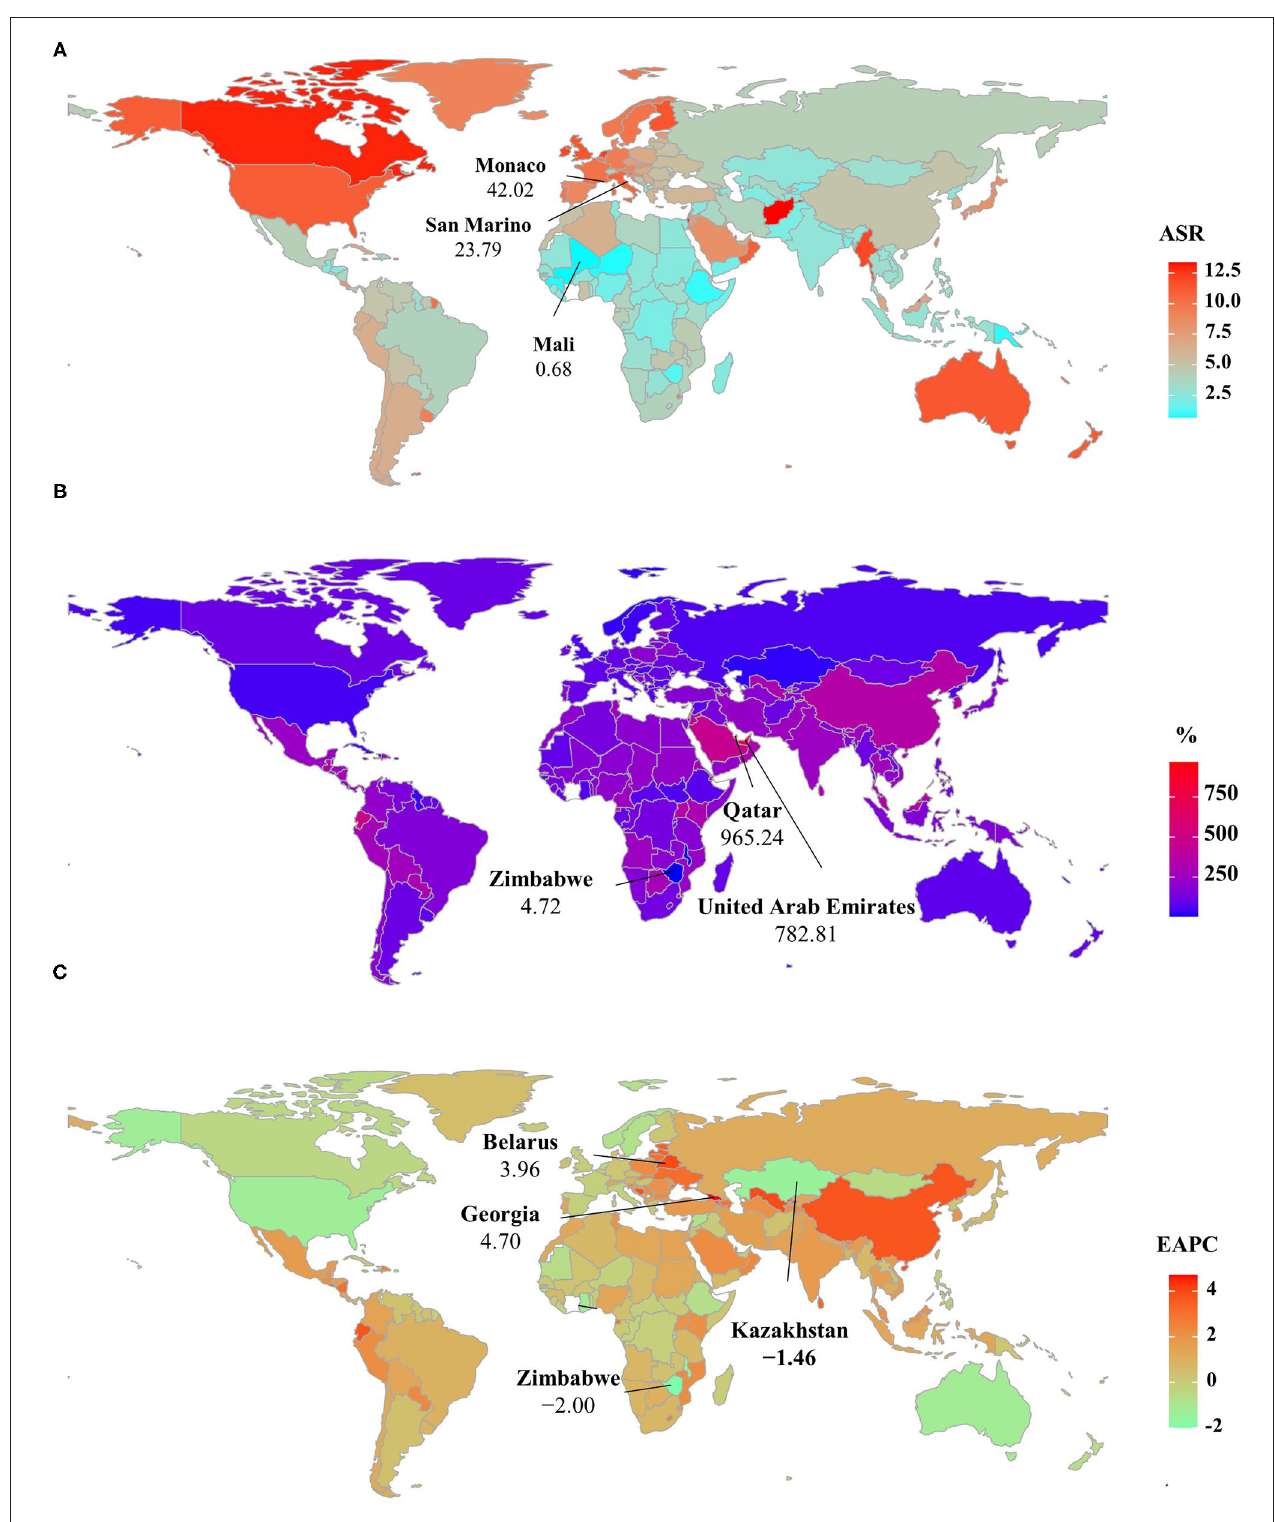
FIGURE 3 | ASIR, percentage changes in the incident number, and EAPCs of non-Hodgkin lymphoma at the national level, 1990–2019. (A) ASIR in 2019; (B) percentage changes in incident numbers between 2000 and 2019; (C) distribution of EAPCs presented in countries/territories. Countries/territories with extreme values were annotated. ASIR, age-standardized incidence rate; EAPC, estimated annual percentage change.